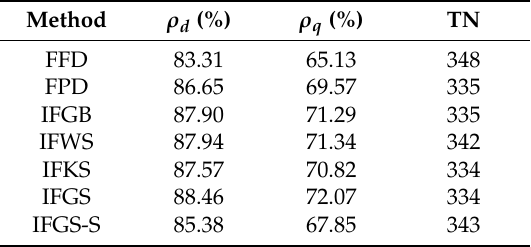
Table 3. Segmentation accuracy measures of the two-look ESAR image.